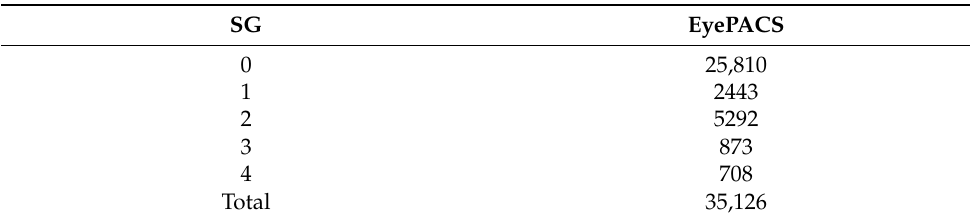
Table 3. Number of images of EyePACS dataset corresponding five different severity grades (SG) of disease, respectively.